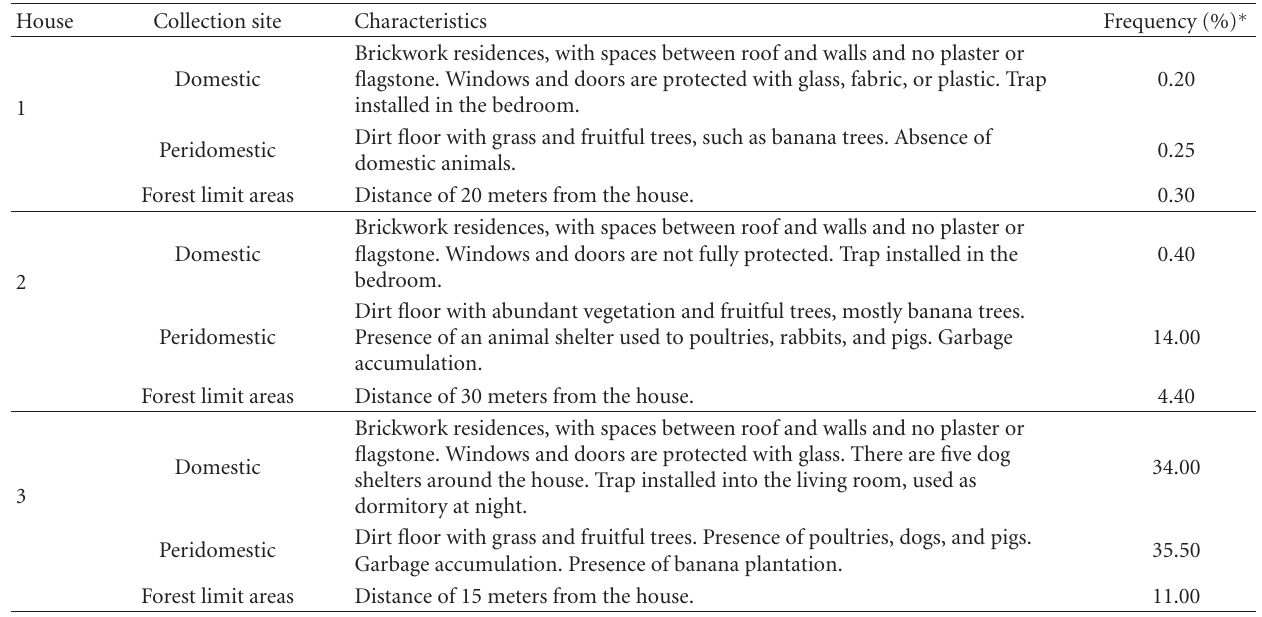
Table 1: Environmental characteristics of collection sites and frequency of sand fly vector species (Caminho da Cachoeira-Campus FIOCRUZ da Mata Atlˆantica, Jacarepagu´a, Rio de Janeiro/RJ), August 2006 to October